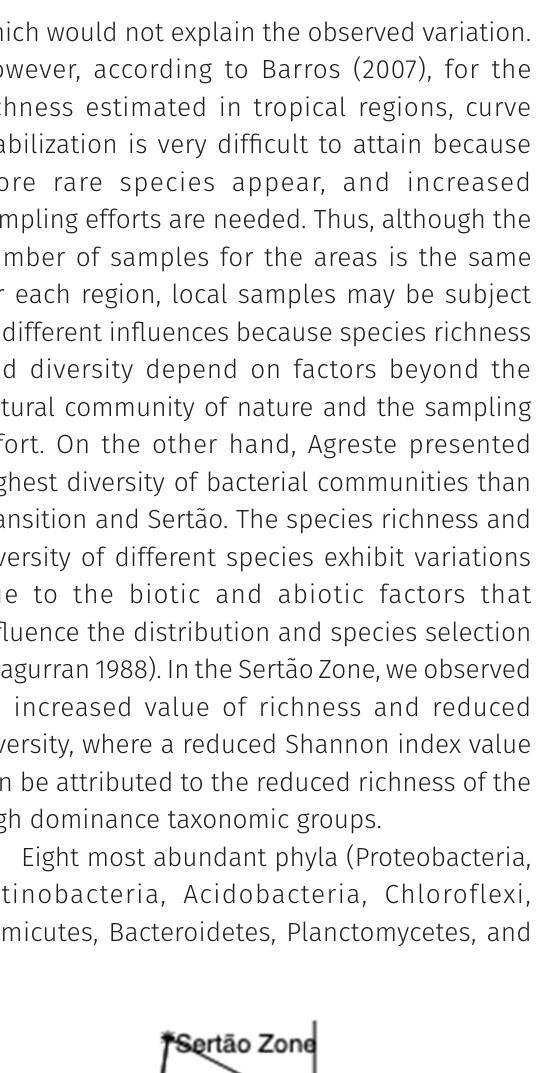
Figure 2. PCoA plots in the mesoregions of the State of